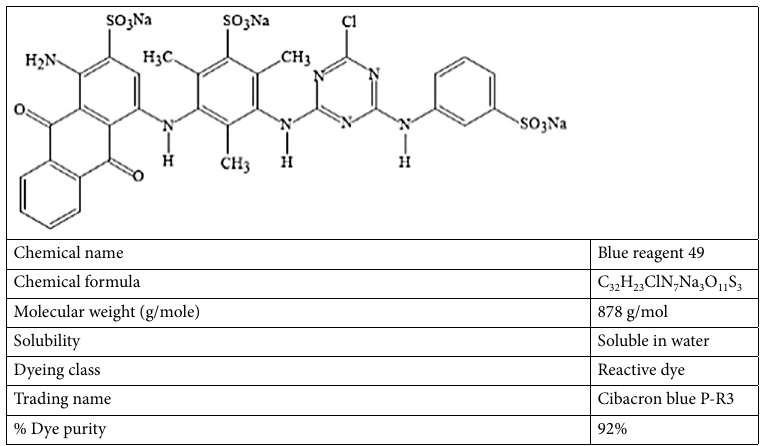
Table 1. Chemical structure and general characteristics of Cibacron blue